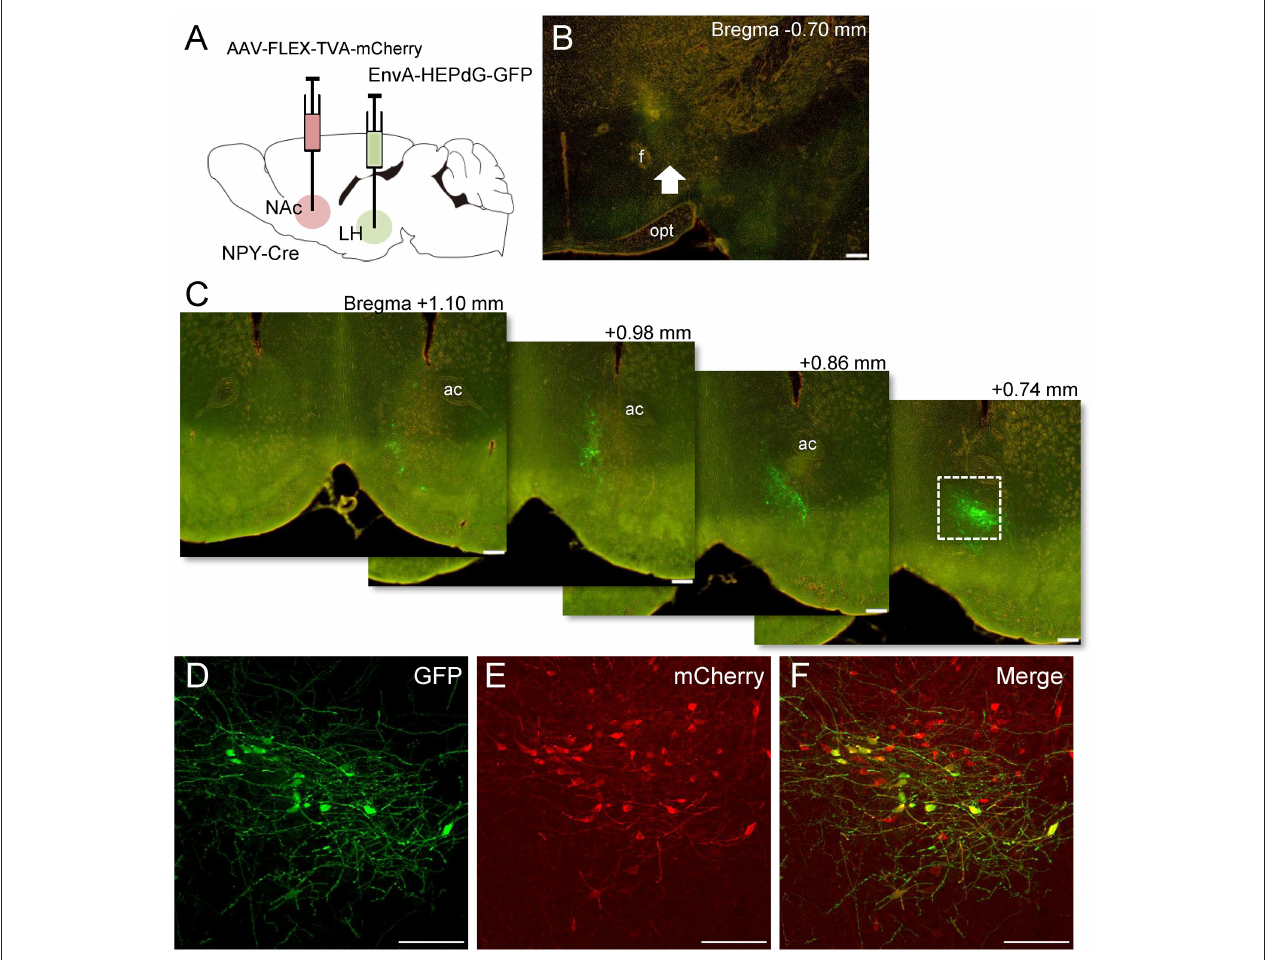
FIGURE 5 | Schematic illustration of AAV(dj)-FLEX-TVA-mCherry injection into the NAc and EnvA-HEPdG-GFP injection into the LH in NPY-Cre mice (A) . Representative photograph of the EnvA-HEPdG-GFP injection site (B) . The arrow shows the injection site. Representative photographs showing the site of GFP expression through the rostral to caudal regions of the NAc (C) . Magnified fluorescence image of GFP (D) , mCherry (E) , and merged (F) in the white square box in C. Scale bars, 100 µ m. Numerical values in or on each photomicrographs show distances from bregma (mm). ac, anterior commissure; f, fornix; opt, optic tract.